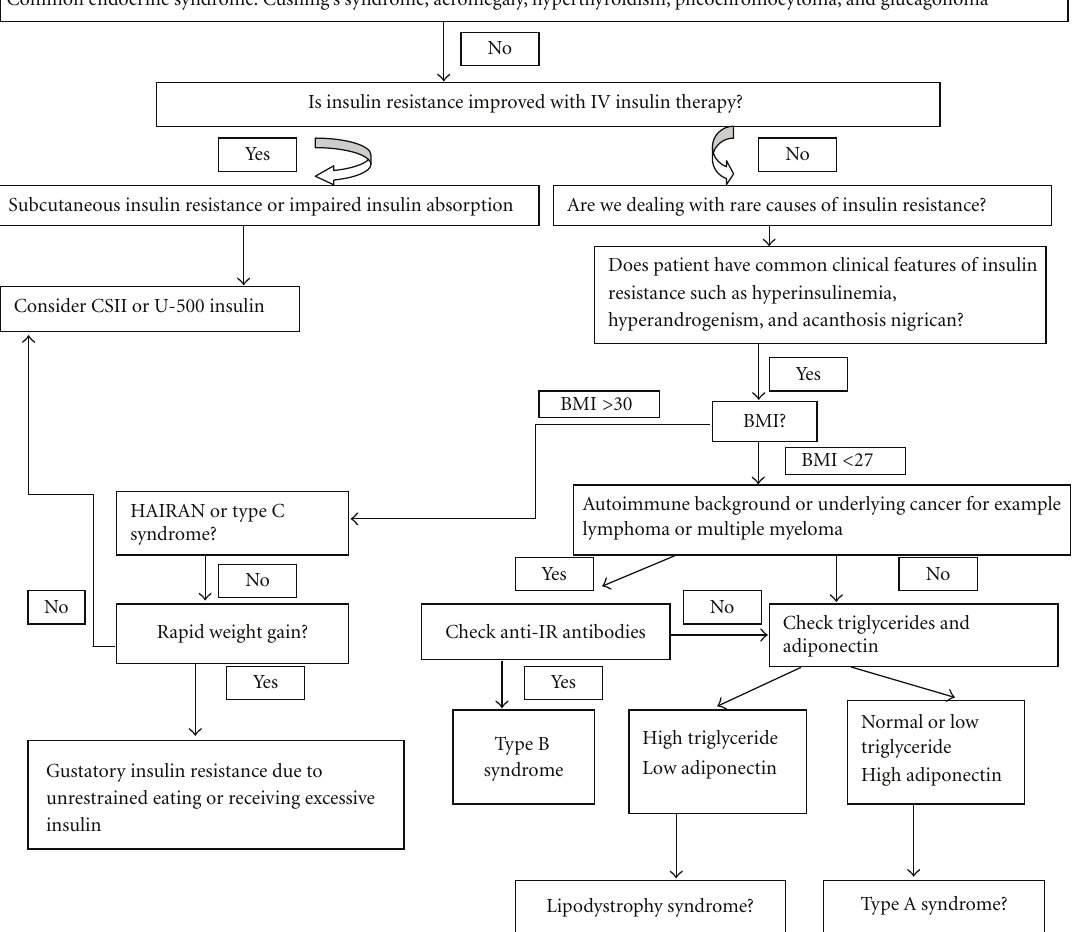
F 2: Outline of a general approach to a patient with insulin resistance (modi�ed from Ovalle F. Diabetes Res Clin Pract. December 2010; 90(3): 231–42)